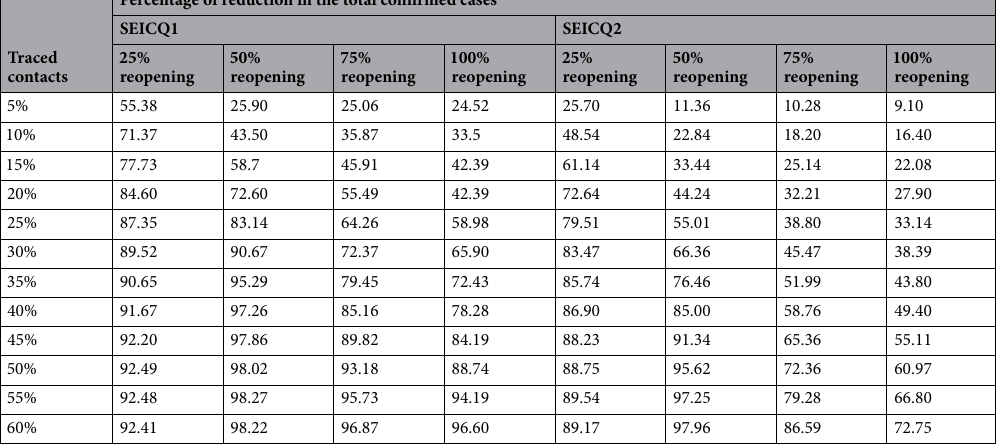
Table 2. Percentage of reduction of the total confirmed cases in eight months after May 4, 2020, in the four reopening scenarios for the two contact tracing mitigation approaches.